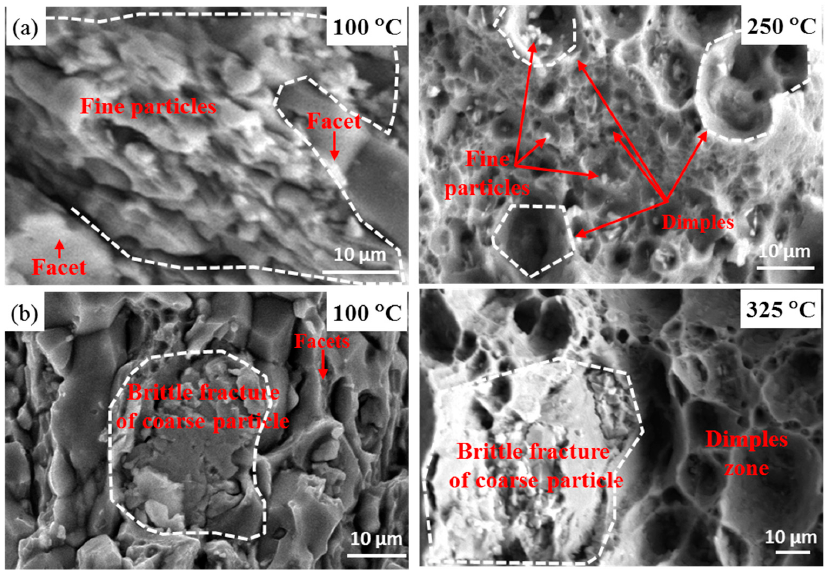
Figure 11. Typical fracture morphologies of ( a ) Ce-containing and ( b ) Ce-free alloys after high temperature tensile at 100 °C, 250 ° C, and 325 °C.